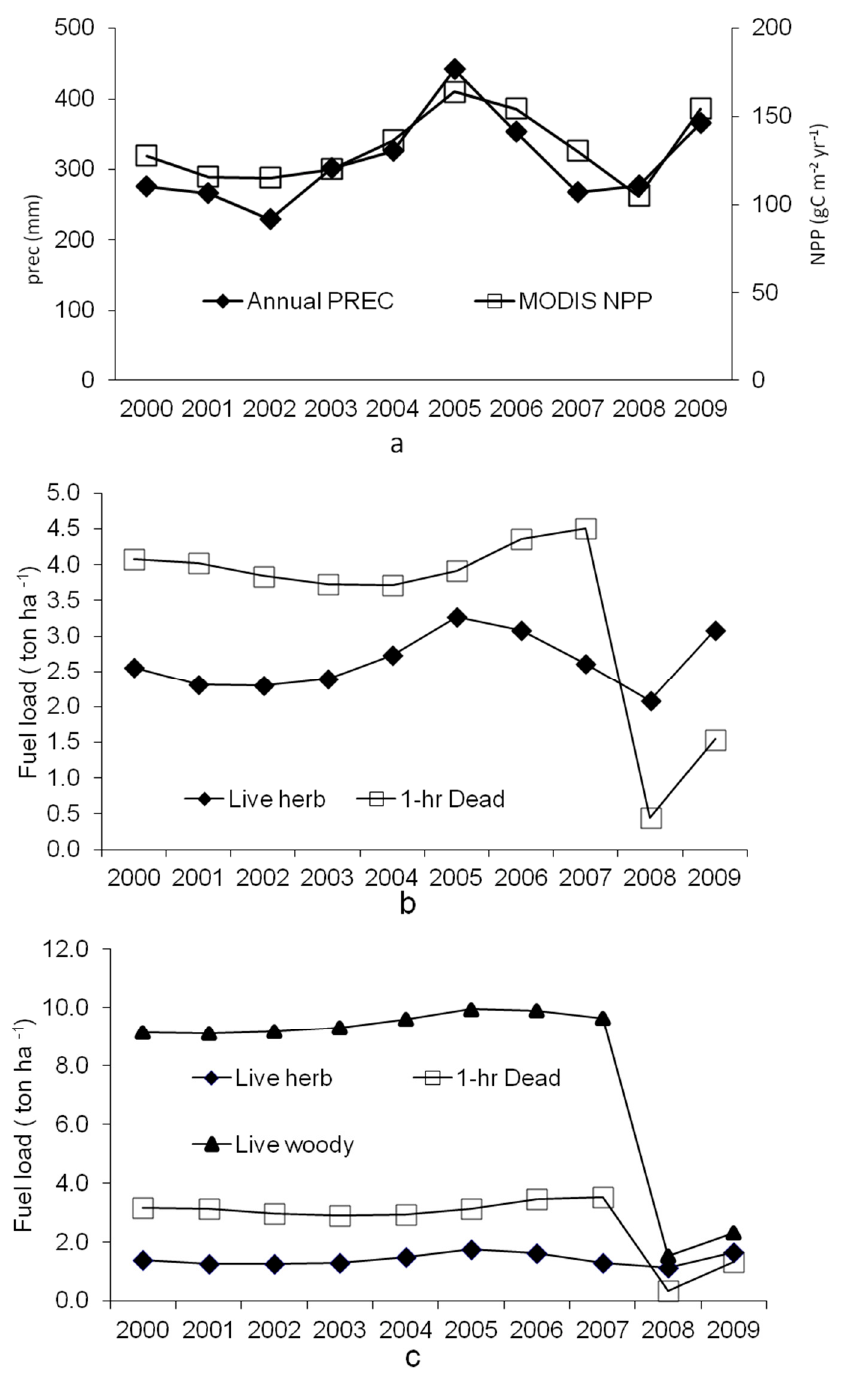
Figure 6. Climate and vegetation condition changes in the Murphy fire region from 2000 to 2009: ( a ) Moderate Resolution Imaging Spectroradiometer (MODIS) net primary production and annual precipitation, ( b ) live herbaceous fuel and 1 h dead fuel changes for fuel type GR2 (low-load, dry-climate grass), ( c ) live fuel, live woody, and 1 h dead fuel changes for fuel type GS2 (moderate-load, dry-climate grass-shrub).